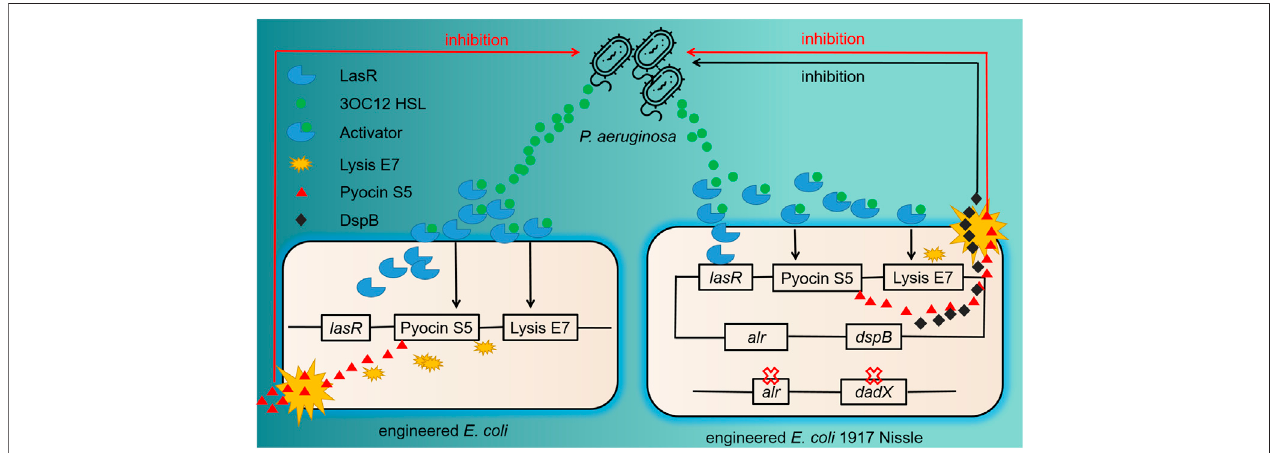
FIGURE 1 | Previous and further improved antimicrobial engineered probiotics through quorum sensing. The left part shows the schematic of the “ sense-and-kill ” system. 3OC12HSL, the quorum-sensing molecule released by P. aeruginosa , binds with LasR to form LasR – 3OC12HSL complex. This complex thereafter activates the production of E7 lysis protein and S5 pyocin. When the accumulation of E7 protein is enough to lead to the cell lysis, Pyocin S5 is released into the exogenous environment and kills P. aeruginosa . The right part shows the improvement of this system. The chromosomal deletion of alr and dadX genes in E. coli Nissle promotes theretentionofplasmid carrying alr gene.Anevident differenceofthekillingpart istheaddition of dspB ,which encodesananti-bio fi lmenzymewithenhanced inhibition ef fi